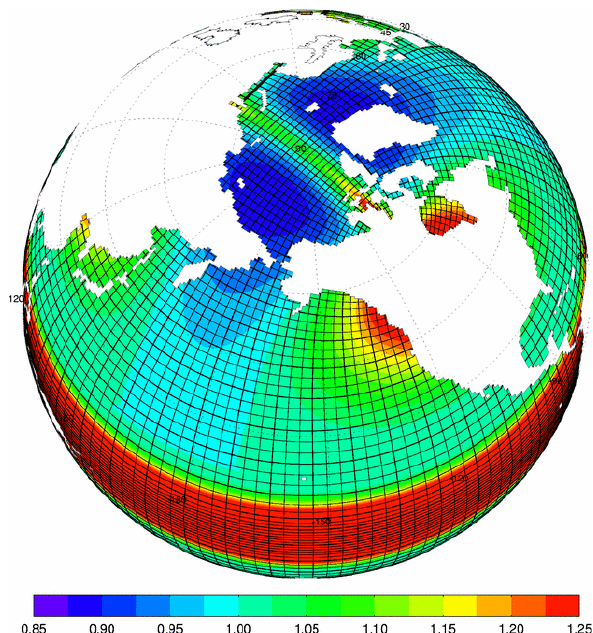
Fig. 2. ORCA1 grid. Every third gridline is plotted. The contoured field is the grid anisotropy, 1 x: 1 y. The tropical grid refinement is clear, as is the quasi-uniform grid in the Arctic. The land sea mask in the Arctic (and elsewhere) has been smoothed to inhibit the build-up of sea ice in narrow channels.